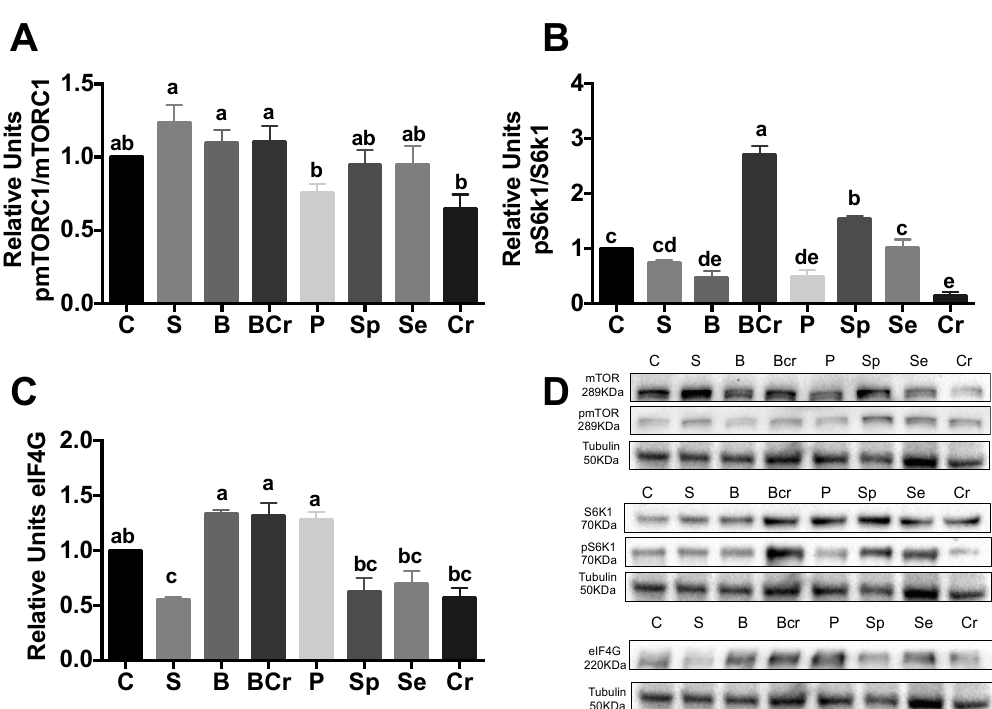
Figure 2. Western blot analysis and quantification of the: ( A ) phosphorylation of mTORC1; ( B ) phosphorylation of S6K1; ( C ) protein abundance of eIF4G in livers of healthy rats fed different types of dietary proteins and ( D ) representative immunoblot. Values are means ± SEM, n = 3. Different letter superscript indicates significant differences among groups, p < 0.05, a > b > c.